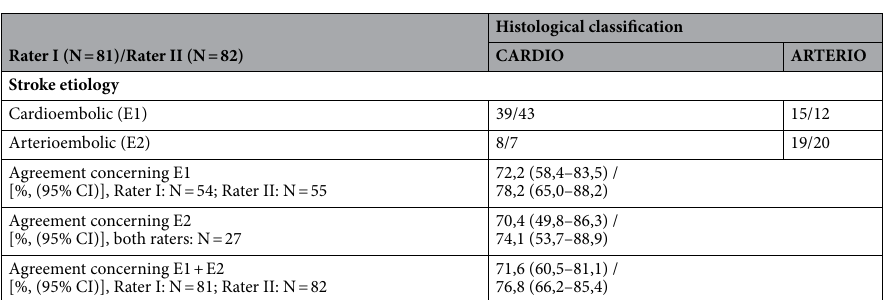
Figure 3. Histological presentation of typical cardioembolic and arterioembolic clots. For the two preparations immunohistochemical staining with CD61 (400-fold original magnification) and hematoxylin–eosin staining (200-fold original magnification) were prepared. The cardioembolic clot (left side) is characterized by a large number of platelets. Their distribution pattern reminds of stratus (rectangle) and cirrus (oval) cloud formations. Many disintegrated neutrophil granulocytes can be seen (arrows). Fibrin net is dense (star). This corresponds to a separation thrombus. In contrast, the arterioembolic clot (right side) is marked by a small amount of platelets arranged like cumulus clouds (dashed ovals). Apart from some disintegrated neutrophils (arrows), many intact neutrophils can be found (circles). Fibrin net is fine to coarse (stars). It is therefore an agglutinative thrombus that presumably arose from the tail part of a mixed-thrombus. Both emboli were extracted from patients with a definite stroke etiology.